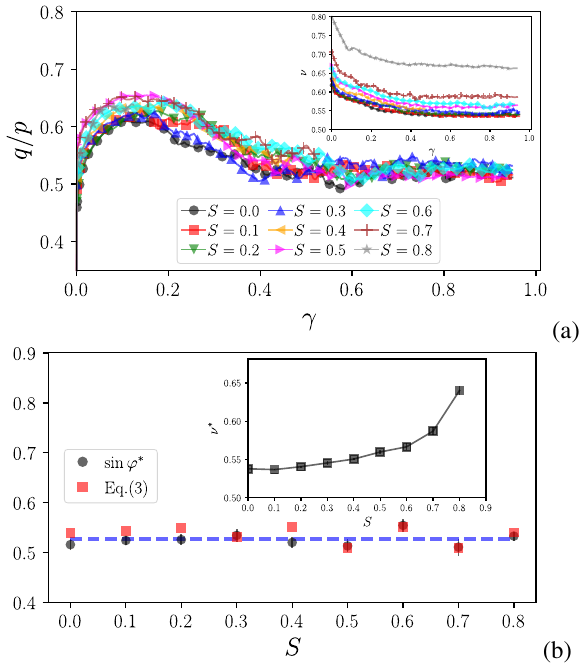
Figure 2. (a) Evolution of the shear strength q / p as a function of the shear deformation  . In the inset: The solid fraction ⌫ as function of  . (b) In black squares: the verage shear strength in the steady state as sin ' ⇤ as a function of S . With red circles: the microstructural prediction of strength strength using Eq. (3). In the inset: The solid fraction at the steady state as a function of S